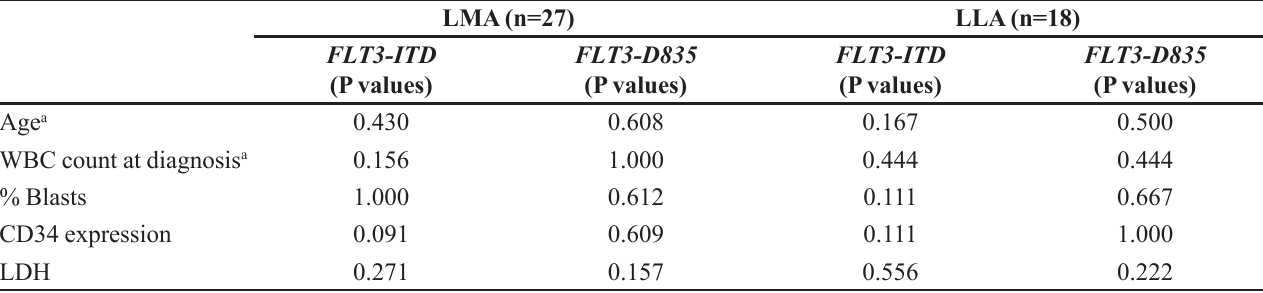
TABLE III - Association between prognostic factors and presence of FLT3-IDT and FLT3-D835 mutations in adults with acute leukemia